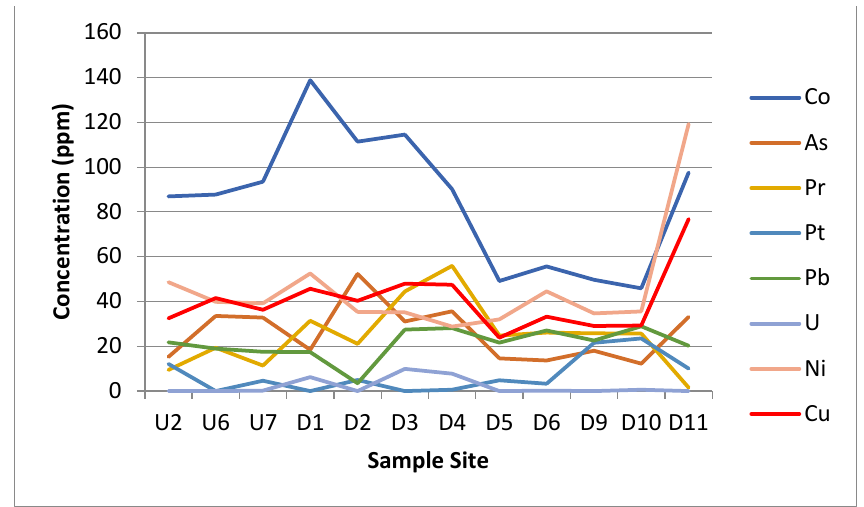
Figure 5. Graphs showing the concentration in parts per million (ppm) of the 23 different elements detected by the XRF. Sample site axis is a proxy for the distance along the transect. Table 8. Table summarising the compounds, retention time of the compounds and abundance per site. The compounds in italics showed a very restricted Table 7. Total organic carbon concentrations (additional potassium dichromate had to be added to the samples U2, D2, D6, D9 and D11).